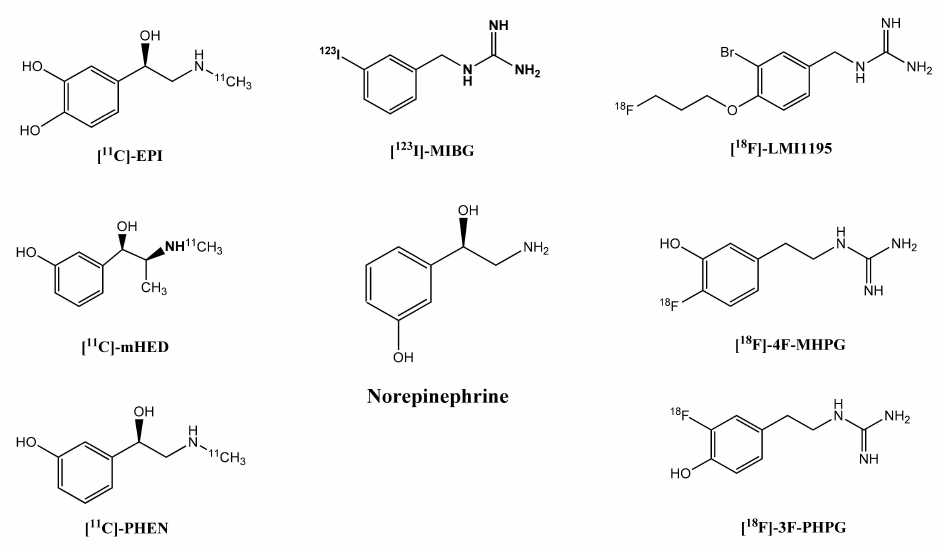
Figure 1. Chemical structures of the norepinephrine and its radiolabeled analogues. ([ 11 C]- EPI:[ 11 C]-Epinephrine, [ 123 I]-MIBG: [ 123 I]-metaiodobenzylguanidine, [ 18 F]-LMI1195: N -[3-bromo- 4-(3-[ 18 F]fluoro-propoxy)-benzyl]-guanidine, [ 11 C]-mHED: [ 11 C]-meta-hydroxyephedrine, [ 11